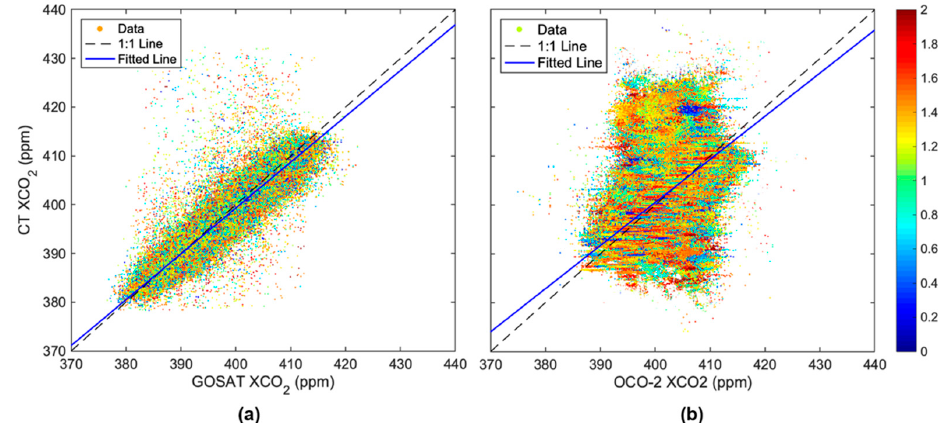
Figure 4. The scatter density plot between the XCO 2 derived from ( a ) the CT and GOSAT; ( b ) and the CT and OCO-2.